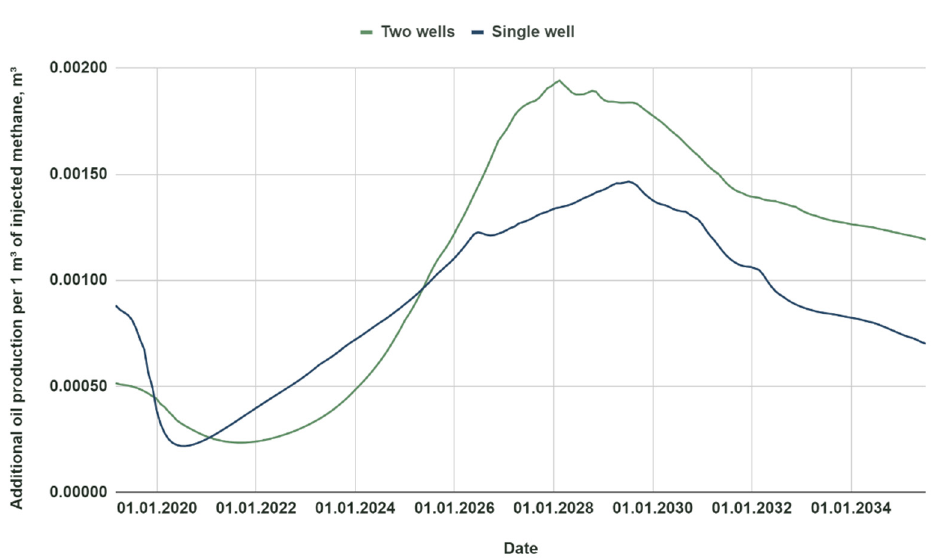
Figure 11. APG utilization efficiency.